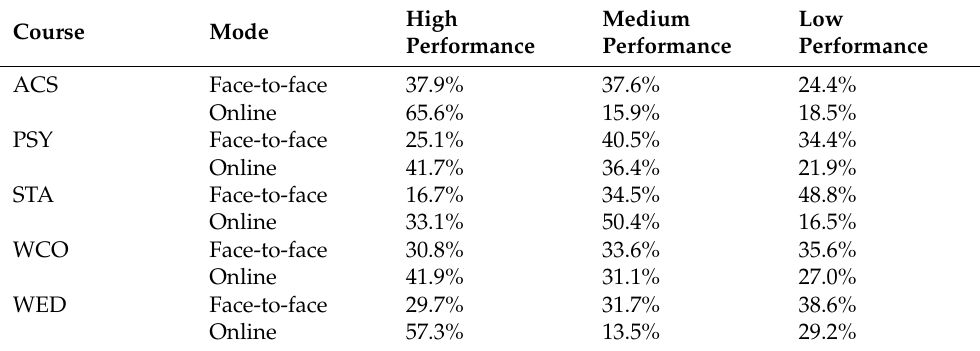
Table 1. Percentage of students with H, M, and L performance by course and instructional